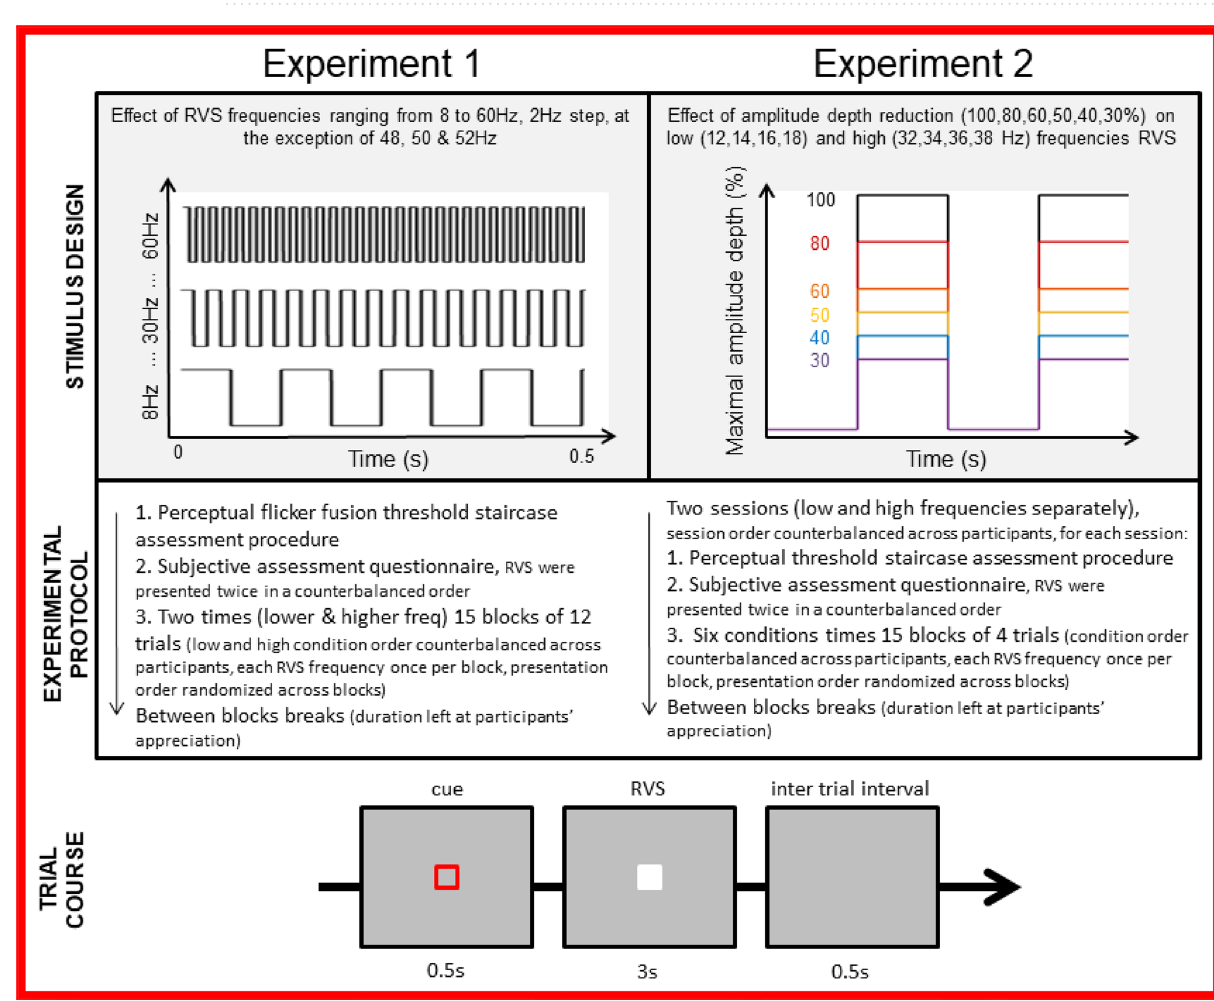
Figure 6. Experiment 3: subjective and classification accuracy results for the different conditions of the online T9 BCI.